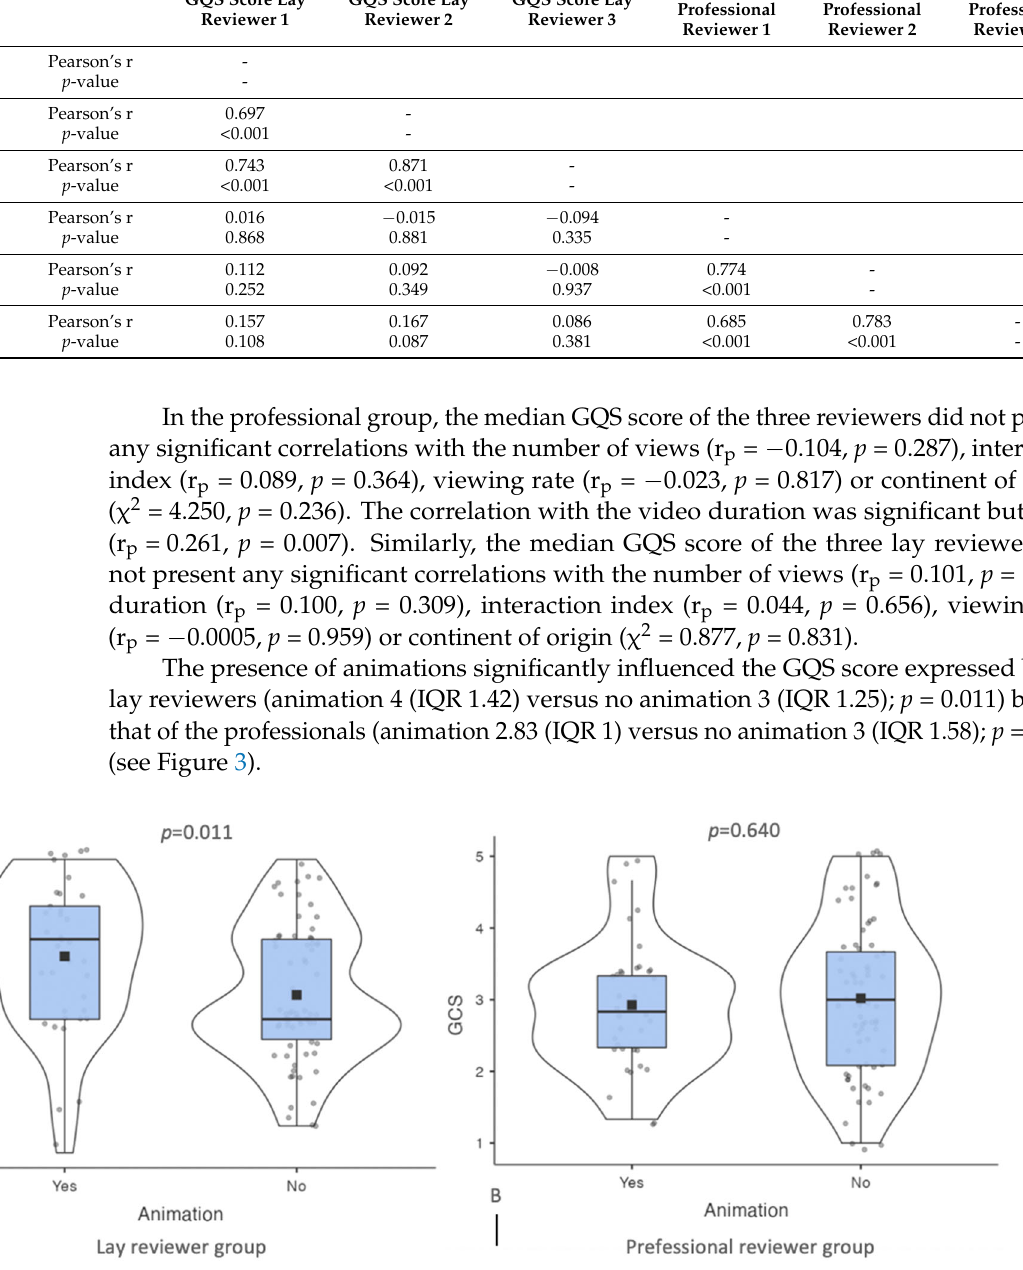
Figure 3. The GCS median differences between the videos with and without animations in the lay and professional reviewer groups.